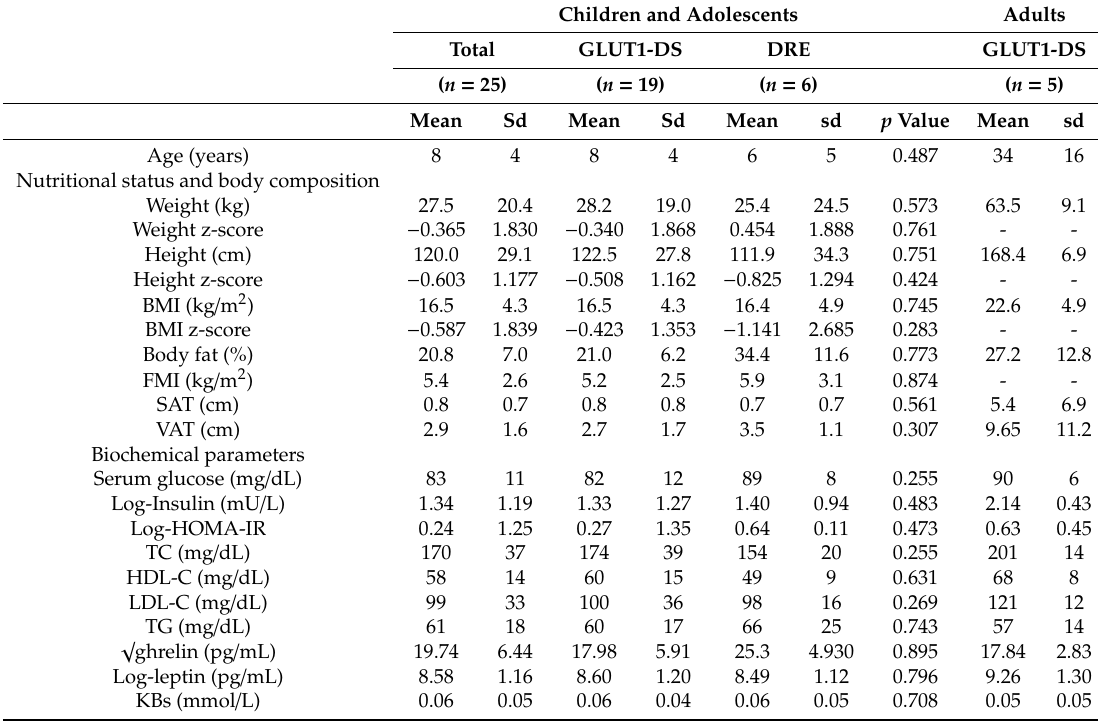
Table 1. Characteristics of the patients at